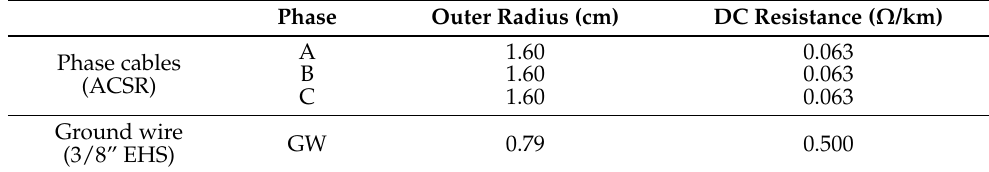
Table 1. Conductors applied to the 138-kV TL.